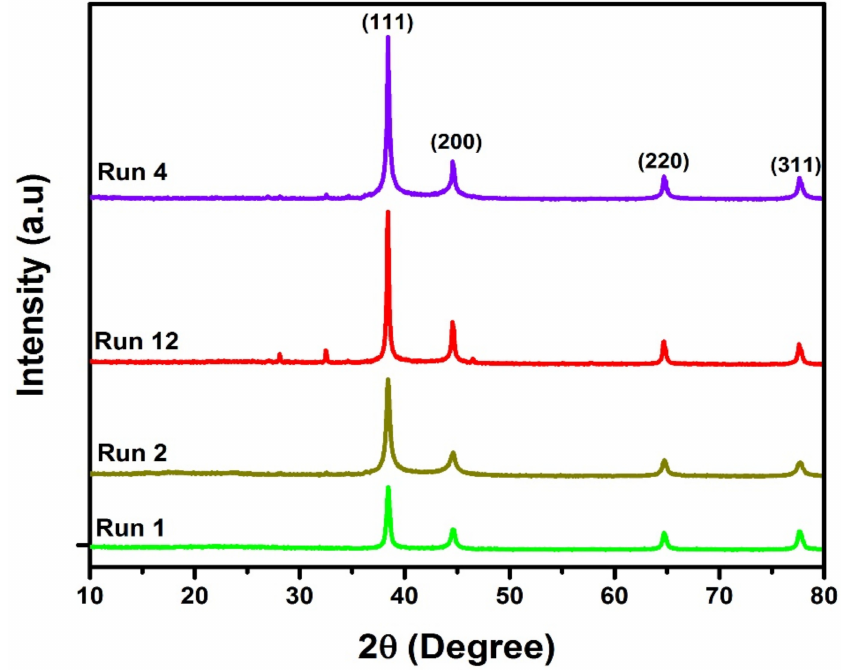
Figure 5. XRD spectra of statistical analyzed AgNPs (runs 1, 2, 12 and 4). The peaks with strong intensities confirm that the particles had a good level of crys- tallinity. The highly intense diffraction peak, computed at 2 θ = 38.39, corresponds to the (111) plane, which is used to determine the average size of the AgNPs, which was ap- proximately 19.89 nm. The XRD results indicated that the AgNPs were highly crystalline, with a FCC crystal structure that was found to be consistent with previously published findings